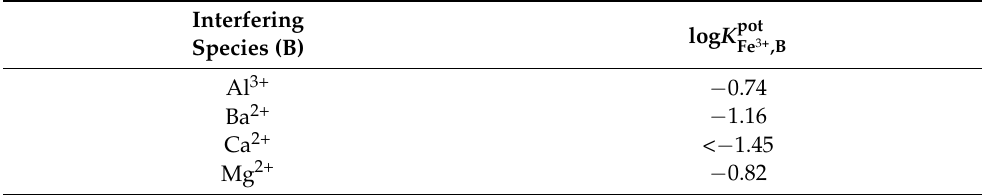
Table 5. Logarithmic potentiometric selectivity coefficient values of M1 membrane in Electrode Body 2.